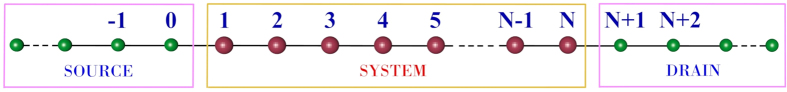
Schematic sketch of the Source-System-Drain bridge.Schematic illustration of the renormalized system coupled in-between two semi-infinite ordered leads.